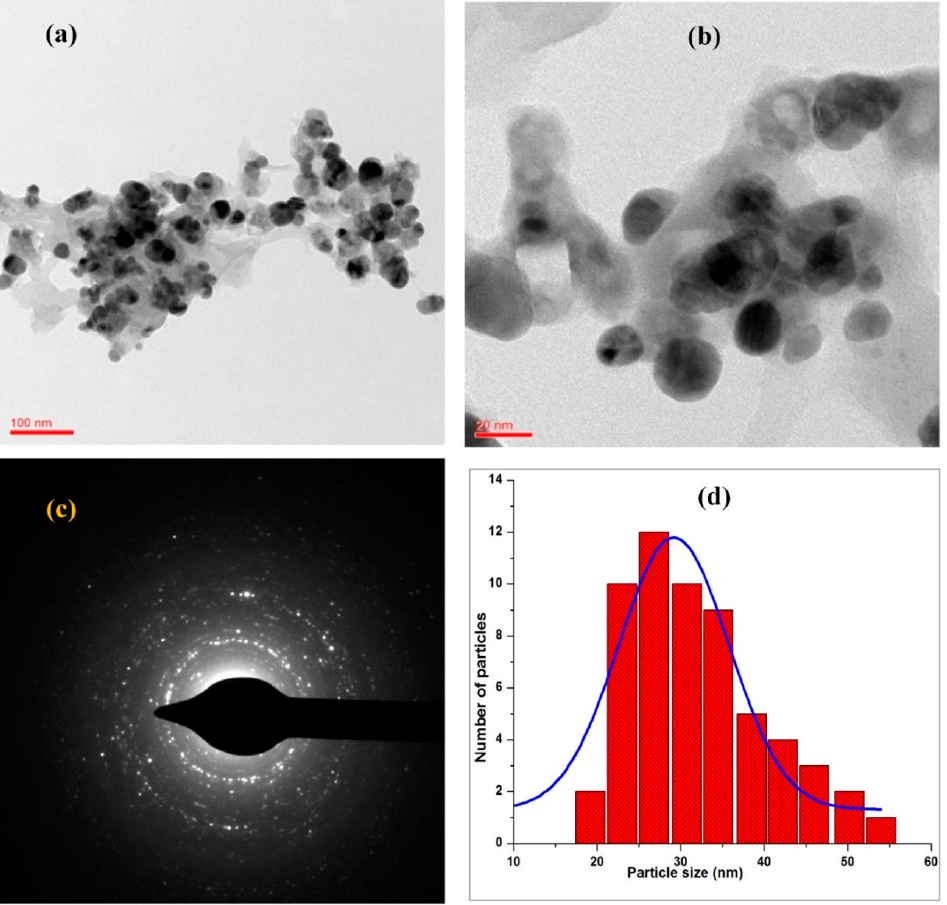
Figure 3. High-resolution transmission electron microscopy (HRTEM) images of GPE-AgNPs at ( a ) 100 and ( b ) 20 nm magnification, ( c ) selected area diffraction pattern (SAED), and ( d ) average particle size histogram of the synthesized GPE-AgNPs.